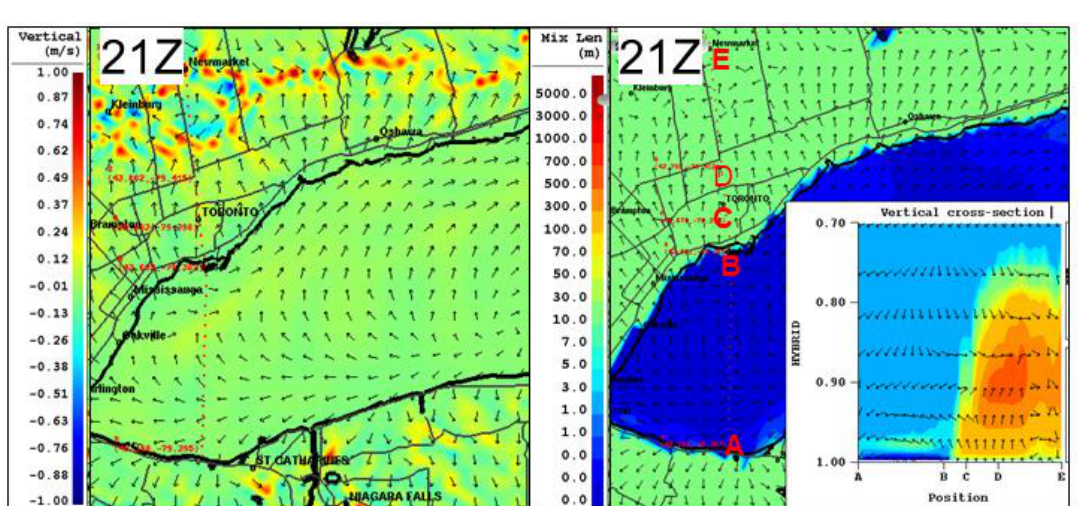
Figure 13. GEM-MACH-TEB predictions for meteorological variables for 21:00 UTC 28 July 2015. Panels are for ( a ) surface air temperature ( ◦ C), ( b ) surface relative humidity (as a fraction), ( c ) vertical wind velocity at 300-m (m / s) and ( d ) surface turbulent mixing length (meters). The inset vertical cross section in panel ( d ) extends from point A (south shore of Lake Ontario) to B (Toronto Island), C (downtown Toronto), D (North Toronto) and E (Newmarket). The white line shown in panel ( d ) marks the inset horizontal axis (from point A to E). The hybrid coordinate of the vertical cross section is terrain-following and can be linked to height above surface as follows: 1.0 is the surface, 0.95 is 500-m above ground level (agl), 0.90 is 1-km agl and 0.70 is 3-km agl. The wind arrows in the vertical cross section do not show all the levels near surface for clarity. The arrows shown in the four panels and vertical cross-section represent wind in horizontal plane. Note that panel ( d ) shows a close-up over the west end of Lake